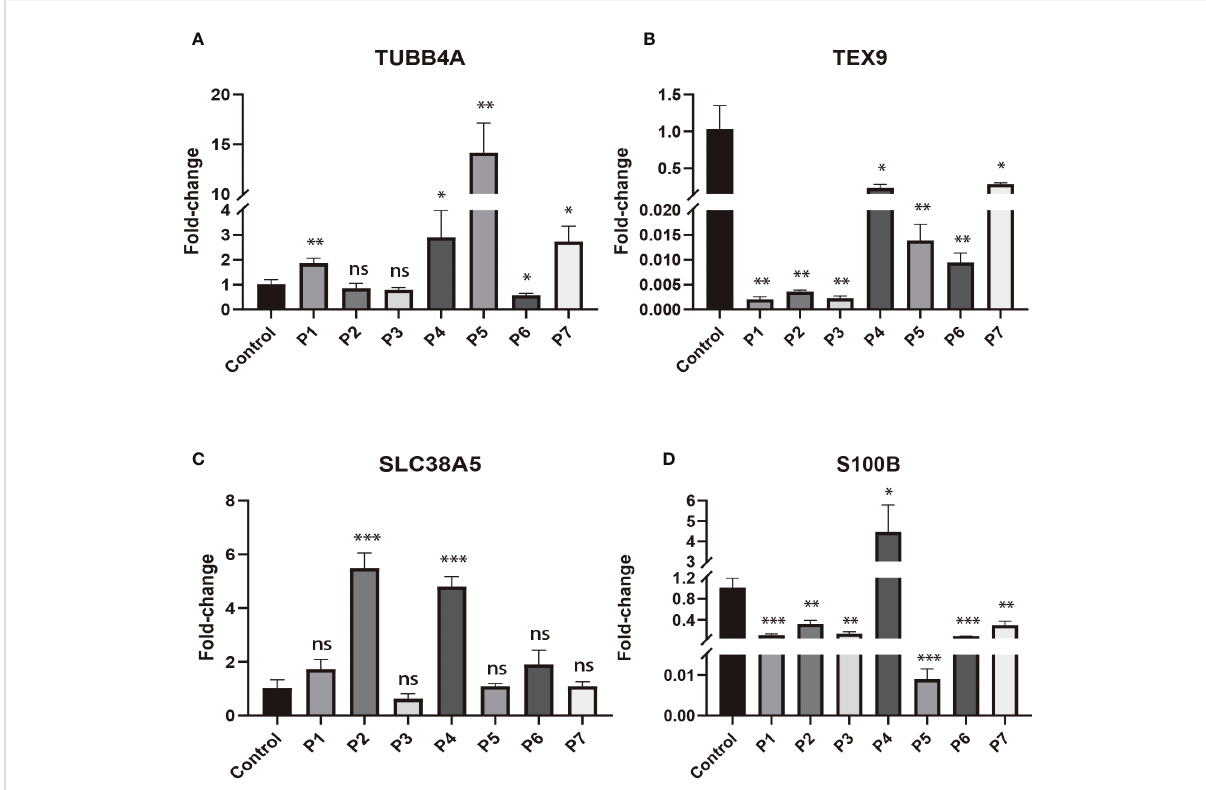
FIGURE 8 The expressions of four signature genes were validated by quantitative real-time PCR (qRT-PCR). *P< 0.05; **P< 0.01; ***P< 0.001; ns, no signi fi cance. (A) The expression of TUBB4A in DLBCL patients. (B) The expression of TEX9 in DLBCL patients. (C) The expression of SLC38A5 in DLBCL patients. (D) The expression of S100B in DLBCL